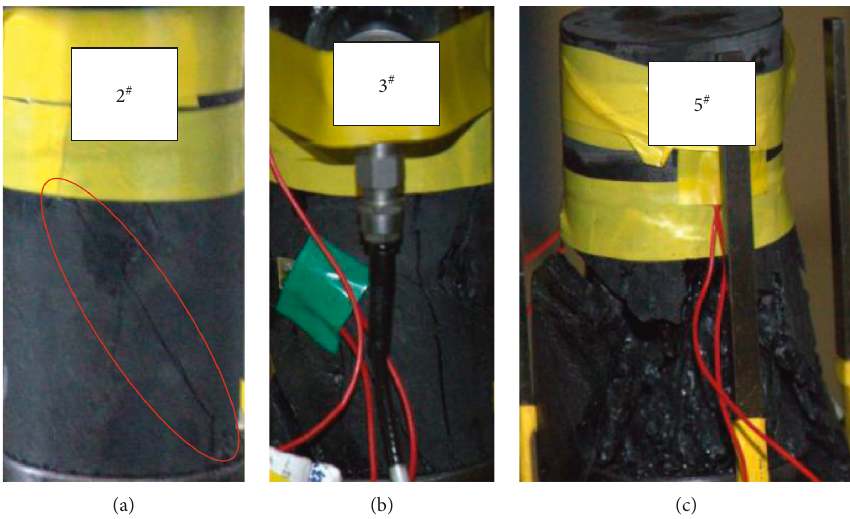
Figure 8: The failure characteristics of coal mass: (a) transfixion crack; (b) surface splitting; (c) overall